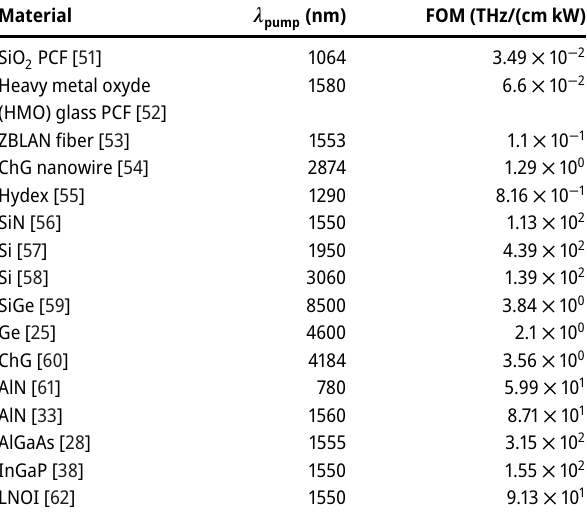
Table 2: FOM for various material platforms as fibers (first 4 rows) or integrated waveguides and the wavelength of the pump used ( λ pump